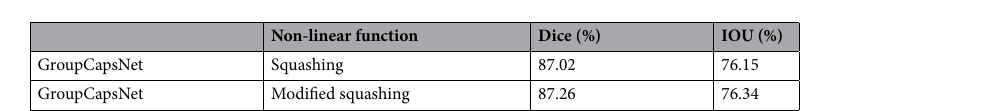
Table 1. Performance comparison of different non-linear mapping